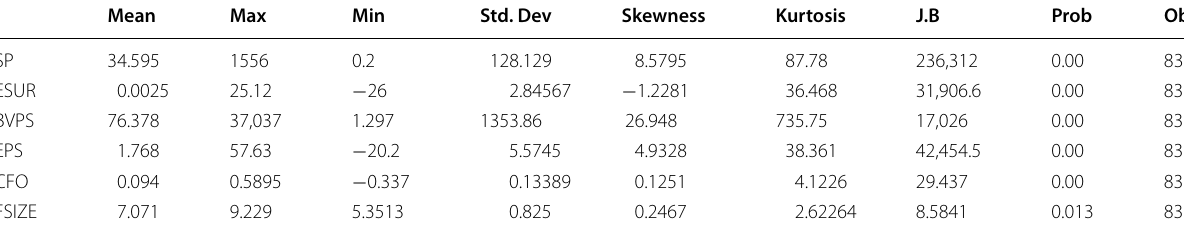
Source: Authors’ Compilation (2022)